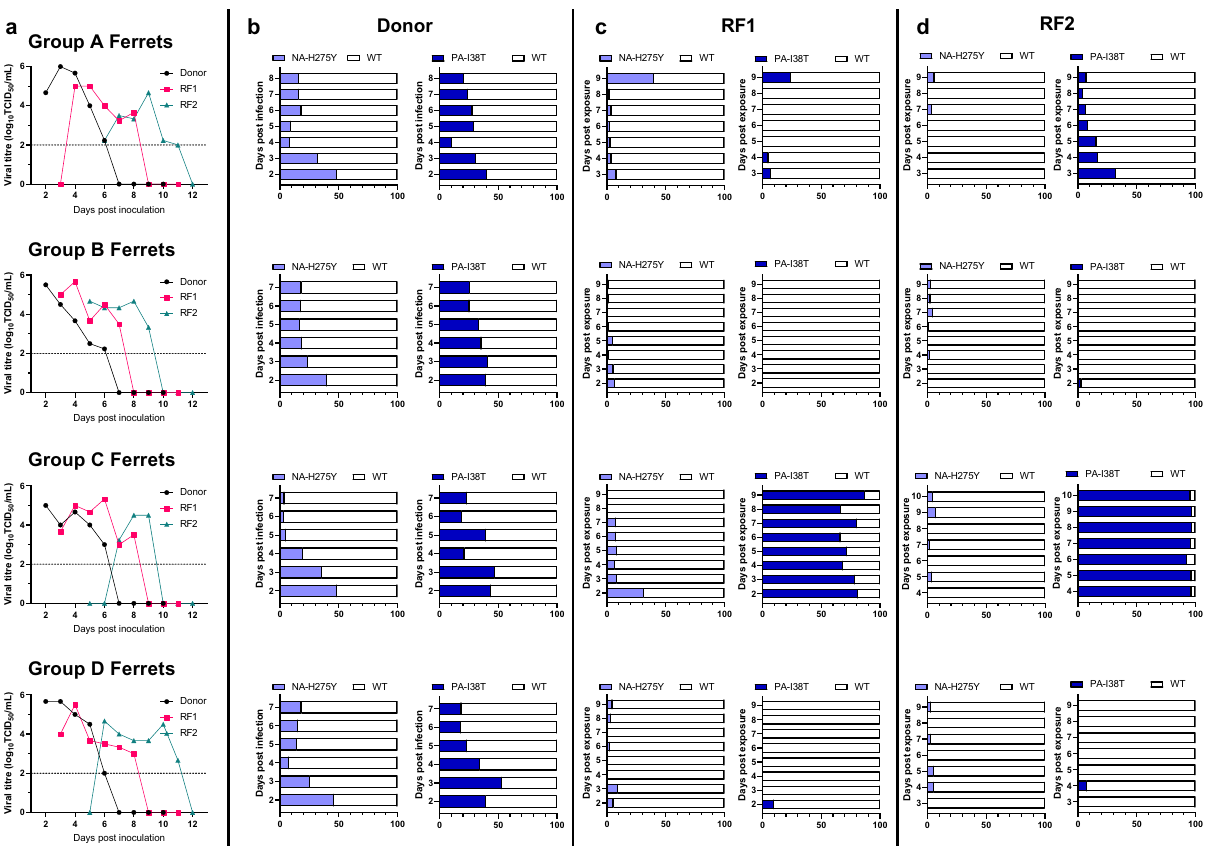
Fig. 4 Infectious virus titres and pyrosequencing analysis of ferret nasal washes from 50:50 WT:NA-H275Y + PA-I38T clinical isolate inoculated donor and airborne transmission infected recipient ferrets. Donor ferrets ( n = 4) were infected via the intranasal route with 5 log 10 TCID 50 /mL with 50:50 WT: NA-H275Y + PA-I38T clinically isolated virus and co-housed with naïve recipient ferrets (RF1) virus separated by an airborne virus permeable barrier, infected RF1s were then co-housed with RF2 ferrets. Nasal wash samples were titrated by TCID 50 assay for each Group A-D Donor-RF1-RF2 transmission pairs, LOD is shown as a dotted horizontal line, and all values beyond LOD equal zero viral titre ( a ). The relative proportion of virus encoding WT PA (white bars) and PA-I38T (dark blue bars) and WT NA (white bars) and NA-H275Y (light blue bars) were determined by pyrosequencing analysis and are shown side-by-side in bar charts for each donor ( b ), RF1 ( c ) and RF2 ( d )